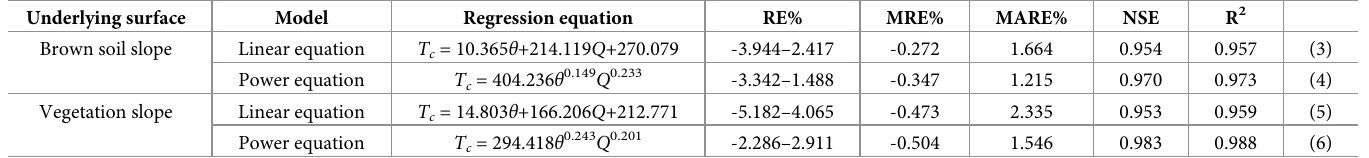
Table 6. Statistical results of predicted and measured sediment transport capacity ( T c ). Underlying surface